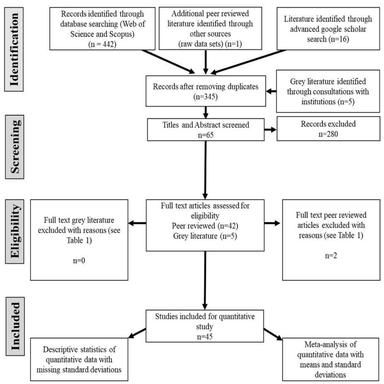
Preferred Reporting Items for Systematic Reviews and Meta-Analyses (PRISMA) flow chart used during the scoping review.